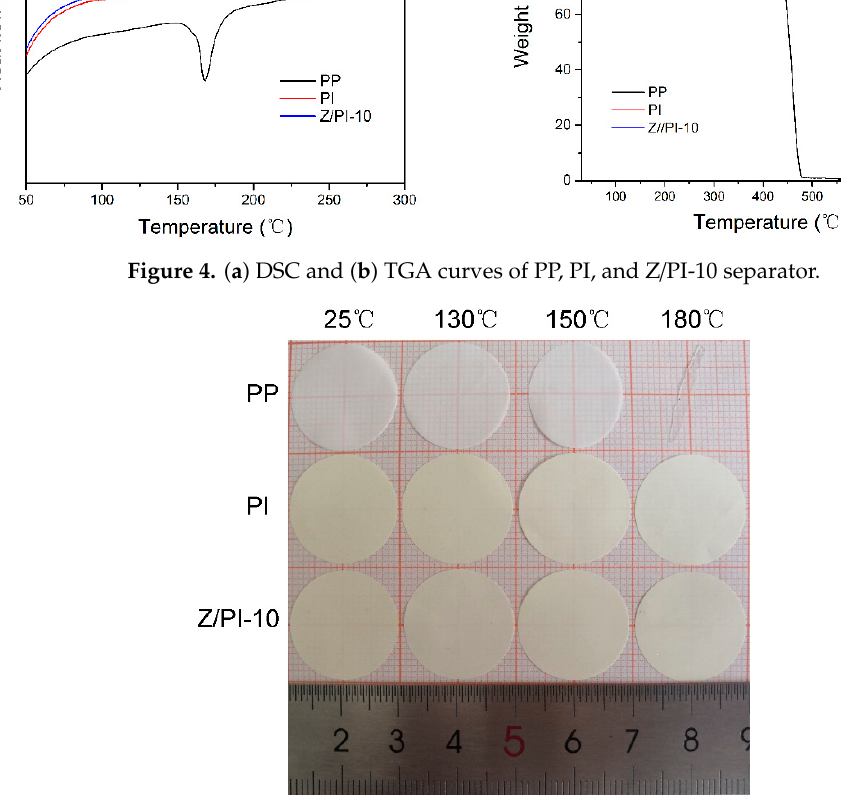
Figure 5. Thermal shrinkage behaviors of the separators after heat treatment at different temperatures for 30 min.